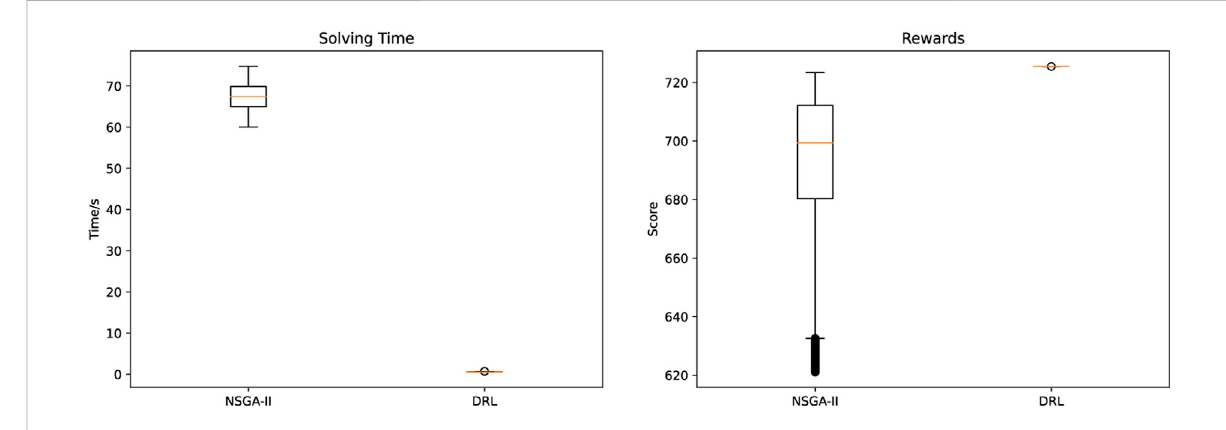
FIGURE 6 The performance comparison.